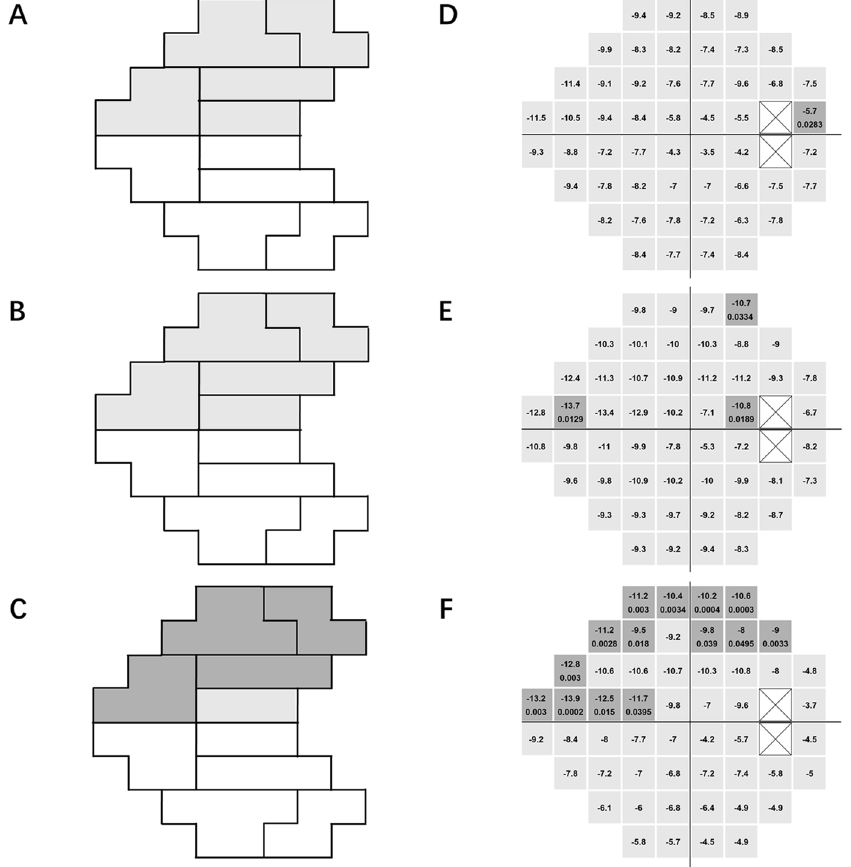
Figure 3. Between-hemifield comparisons of GHT regions and pointwise locations among the matched subjects. (A–C) show the comparisons of regions. (D–F) show the comparisons of pointwise locations. (A,D) represent PACG; (B,E) represent HTG, and (C,F) represent NTG. The dark-shadow regions and dark-shadow points represent significantly worse TD values than their inferior hemifield counterparts (P < 0.05). Image was